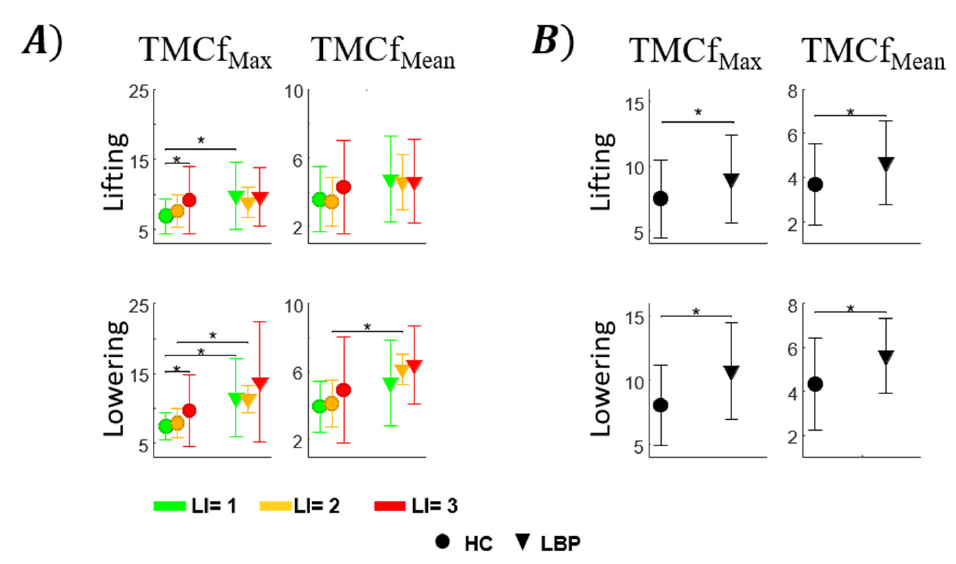
Figure 3. Mean ± SD for each risk level in both groups for the mean (TMCf Mean ) and the maximum (TMCf Max ) values of TMCf function considering all repetitions within the entire session, in lifting lowering phases ( A ) and considering the first 5 cycles for each lifting conditions ( B ). TMCf: Time- varying multi-muscle coactivation function. [* statistical significance ( p < 0.05)].